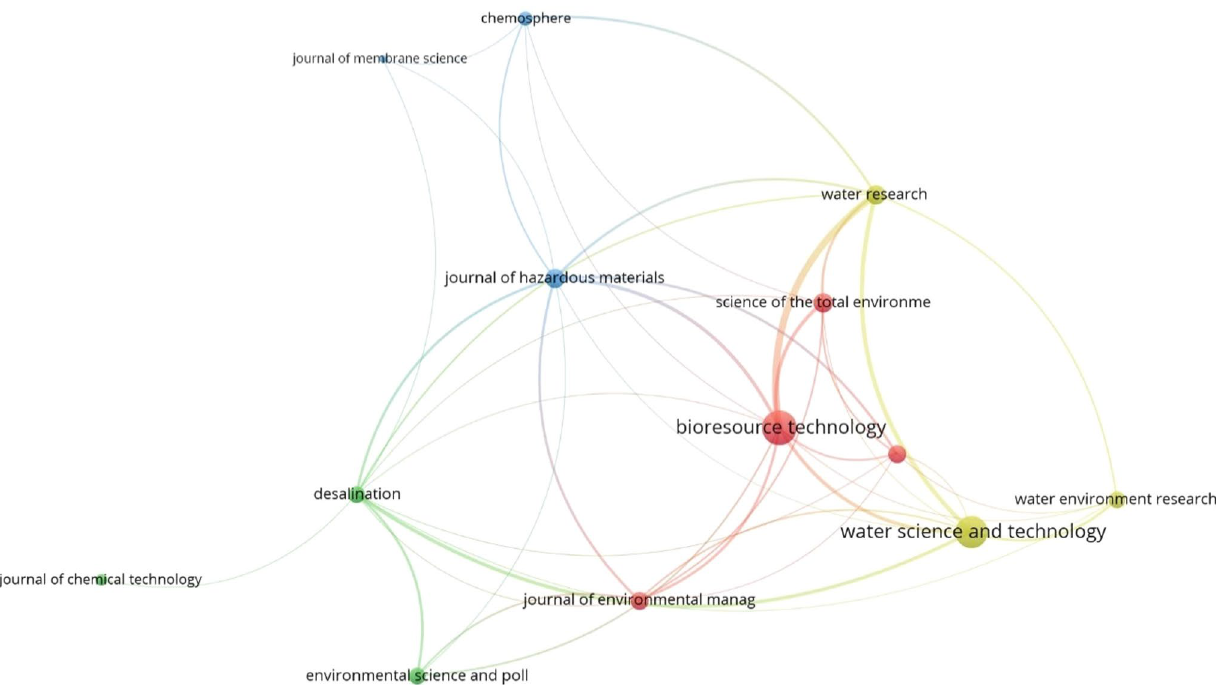
Fig. 4 Network visualization of sources of top 10